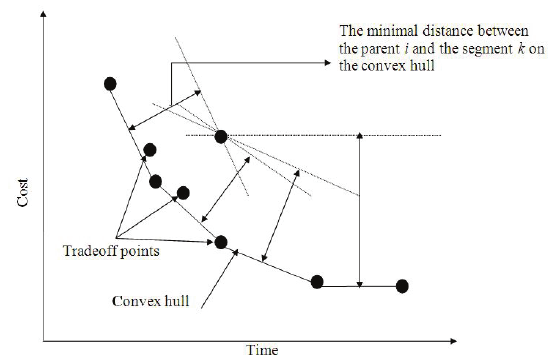
Fig. 2. Fitness evaluation of each member of the